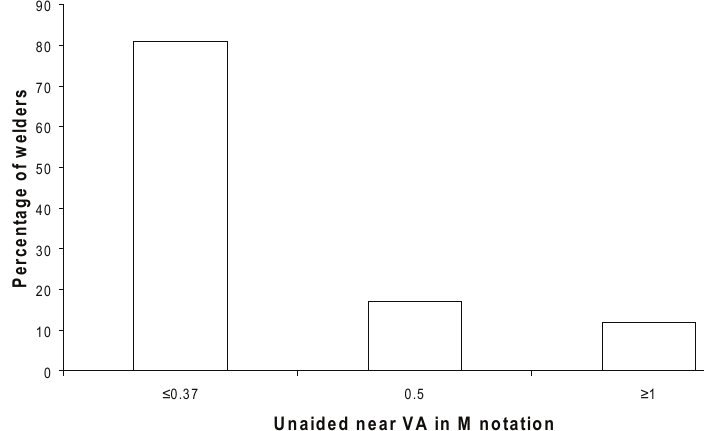
Figure 4: Showing the number of welders who read near VA. The majority (81%) could read ≤0.37